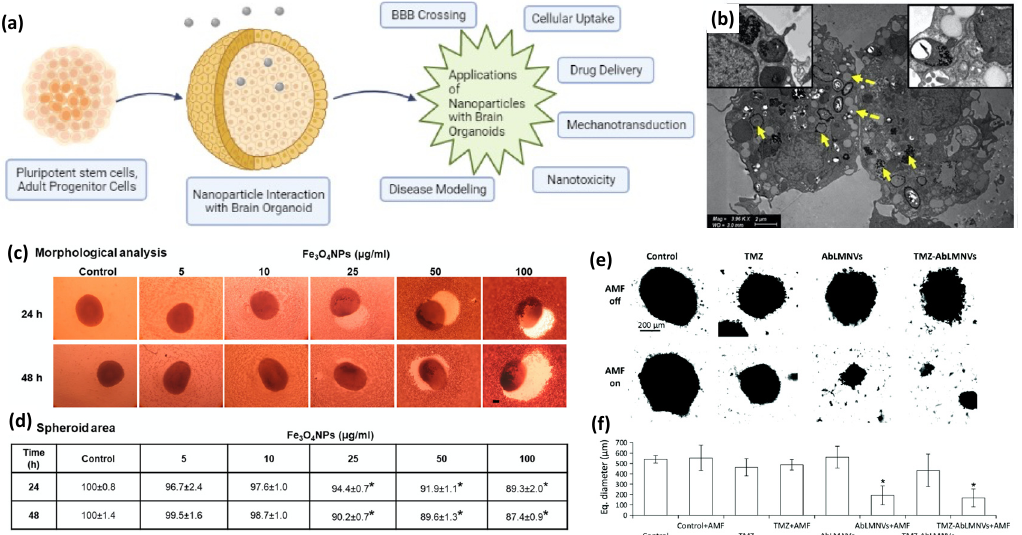
Figure 8. The formation and potential applications of brain organoids to analyze NP effects for neu- roregeneration. ( a ) Schematic of brain-organoid formation and potential NP interactions to facilitate development of therapeutic nanomedicines for neuroregeneration (created with BioRender.com); ( b ) AuNP uptake in 5-cell brain organoids inside microglia (yellow arrows) and surrounding endo- somes and lysosomes (Copyright 2022 by Elsevier); ( c ) morphological and ( d ) area estimation of human-umbilical-cord mesenchymal stem cell-derived brain organoids after 24 and 48 h exposures to iron oxide NPs (5–100 μ g/mL) (Copyright 2022 by John Wiley and Sons); ( e ) transmitted light images and ( f ) size analysis of glioblastoma organoids after 4 days of AMF treatment demonstrating the disintegrative effect of AbLMNVs and TMZ-AbLMNVs. * p < 0.05 was statistically considered